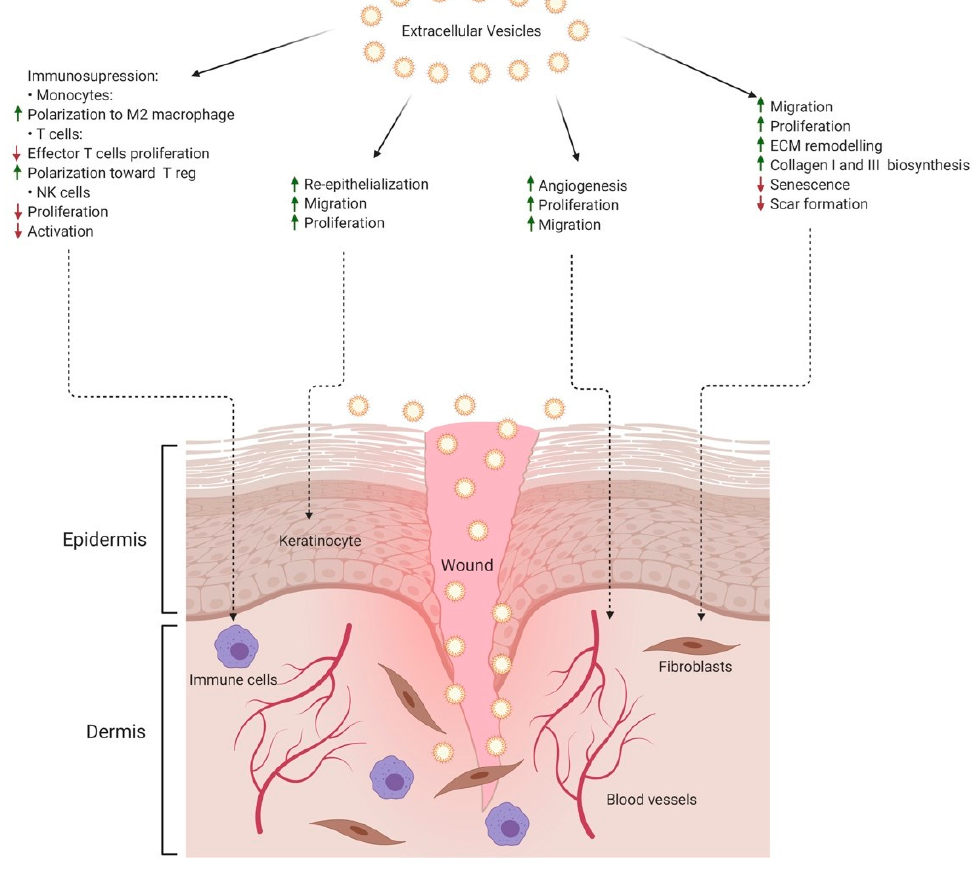
Figure 3. Potential effects of stem cell (SC)-derived EVs/Exs on skin wound healing. 5. SC-Derived EVs/Exs as Nanomedicine Therapeutics for Chronic Skin Inflammation